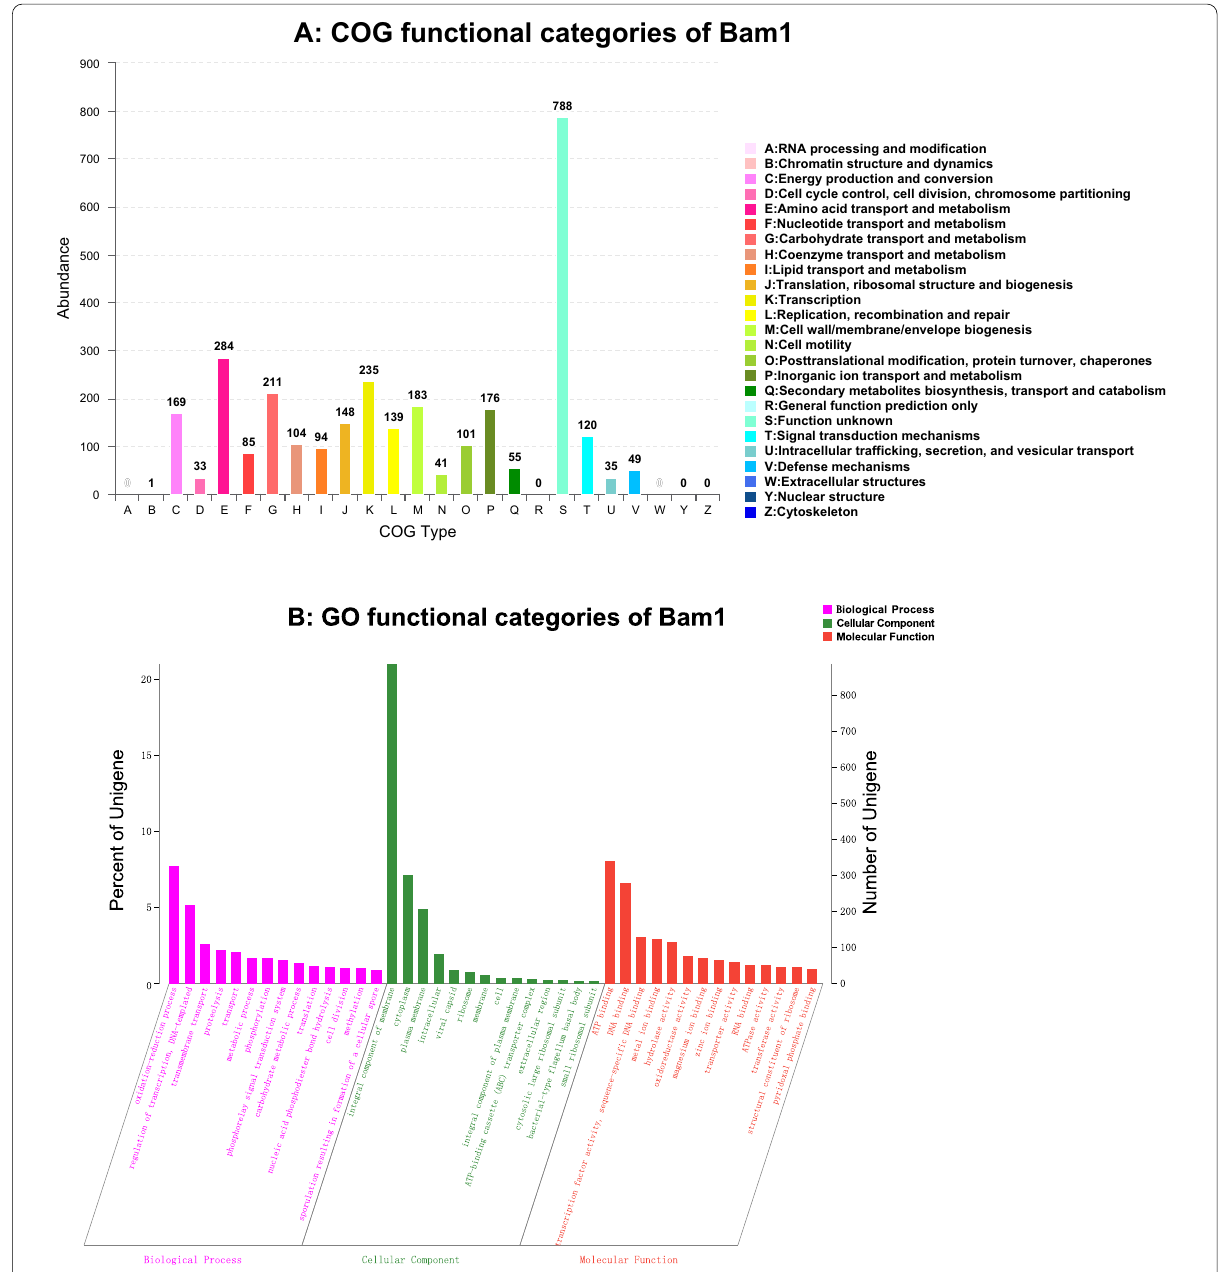
Fig. 2 Distribution of genes across COG and GO functional categories in the chromosome of B. amyloliquefaciens strain